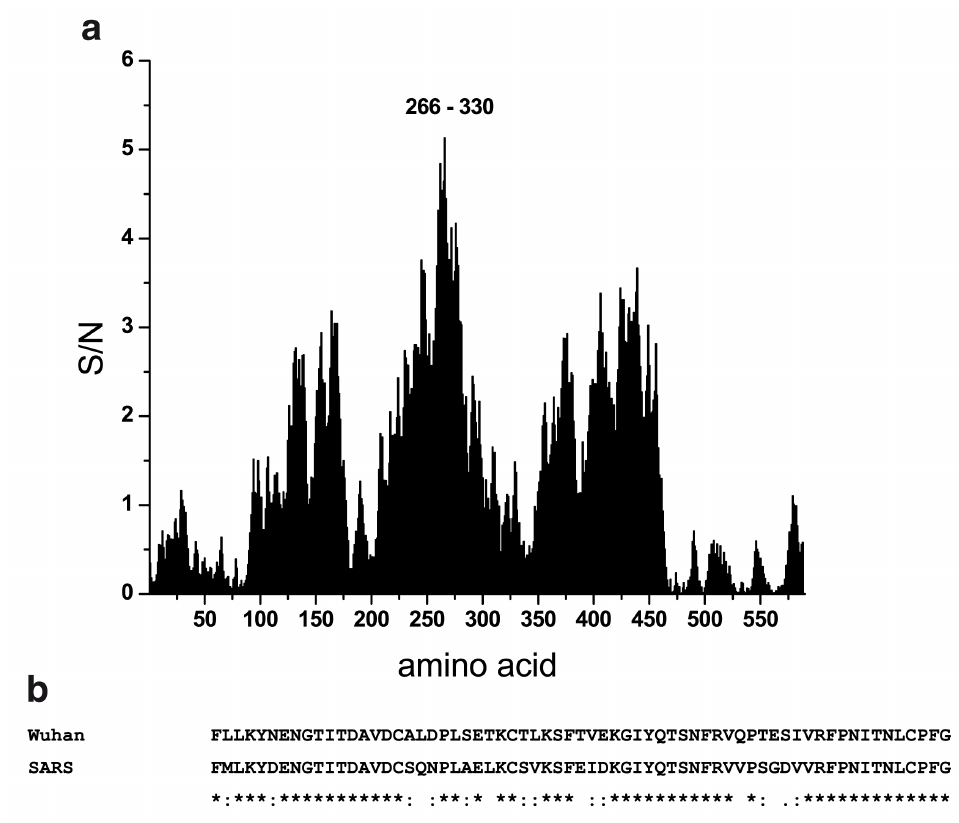
Figure 4. Domain of S1 protein which is important for SARS-CoV-2/ACE2 interaction. ( a ) Mapping of the domain of S1 protein from SARS-CoV-2 (BetaCoV/Wuhan/IVDC-HB-01/2019) which gives the dominant contribution to the information represented with the frequency F(0.257). ( b ) Sequence homology between domains of S1 proteins from SARS-CoV and SARS-CoV-2 with essential contribution to the information corresponding to the frequency